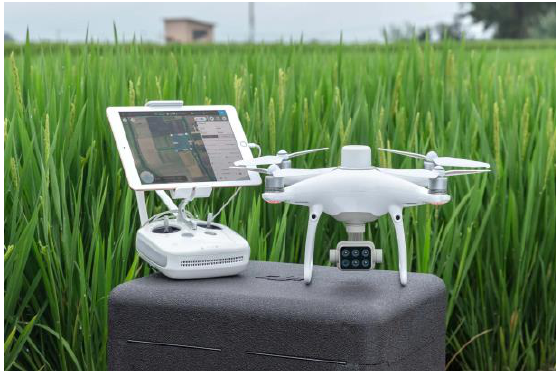
Figure 2. DJI PM4 UAV